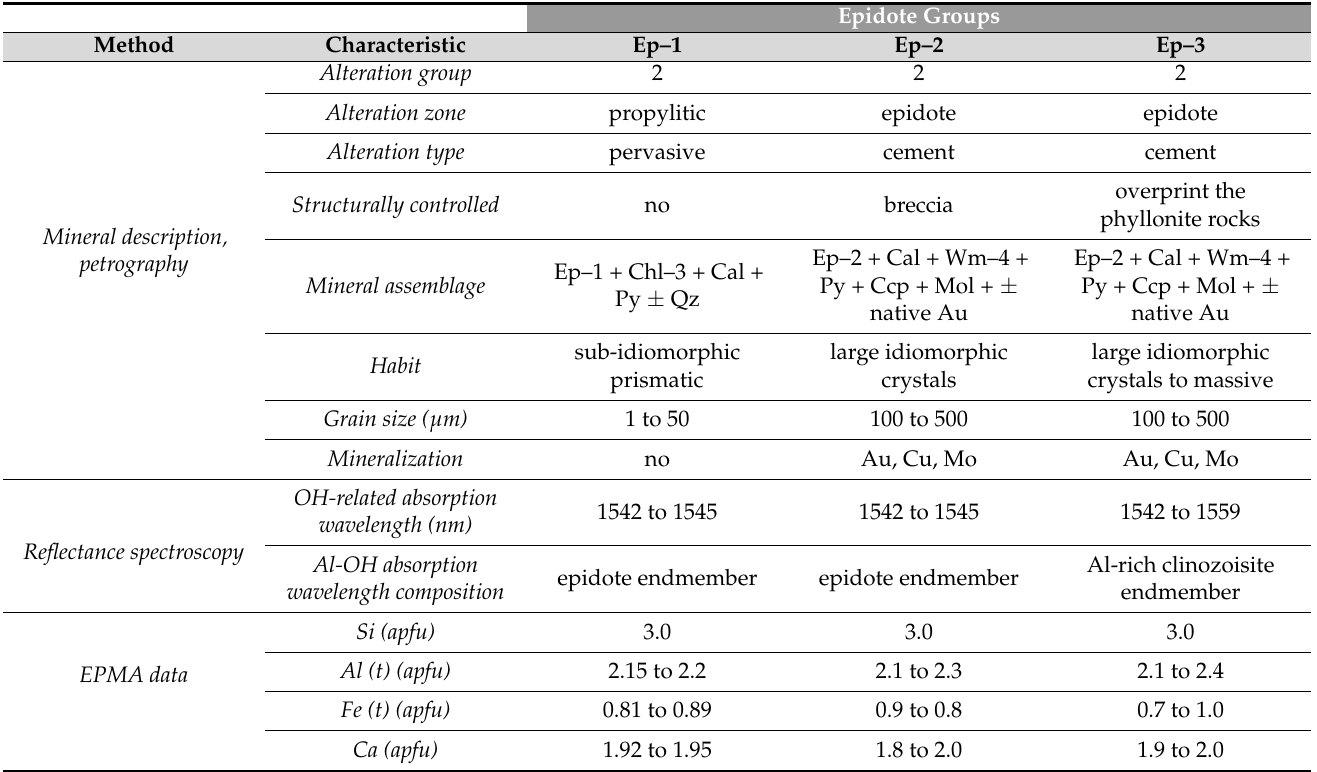
Table 4. Summary of the three epidote groups of the Para í ba deposit, based on the mineral character- istics, drill-core logging, petrography, reflectance spectroscopy, and EMPA-derived data based